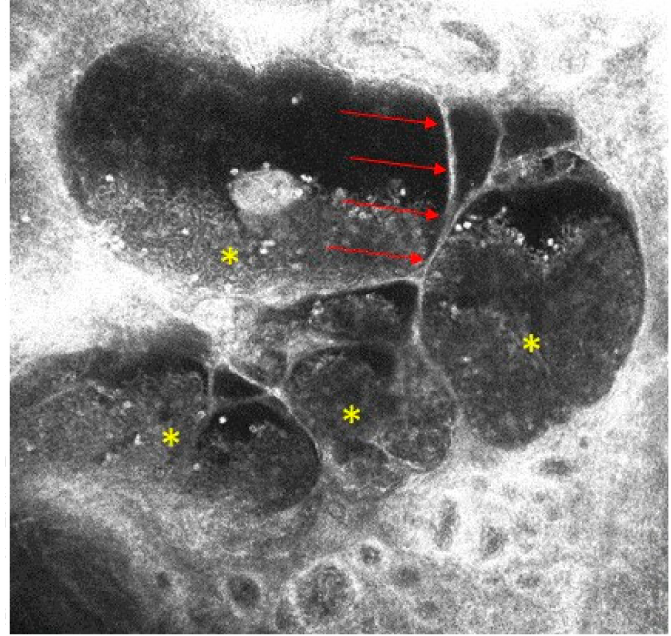
Figure 2. Handheld reflectance confocal microscopy examination of an angiokeratoma. Hypo-reflective oval areas separated by fine septa ( → ) and containing hyper- and medium-reflective cells are visible